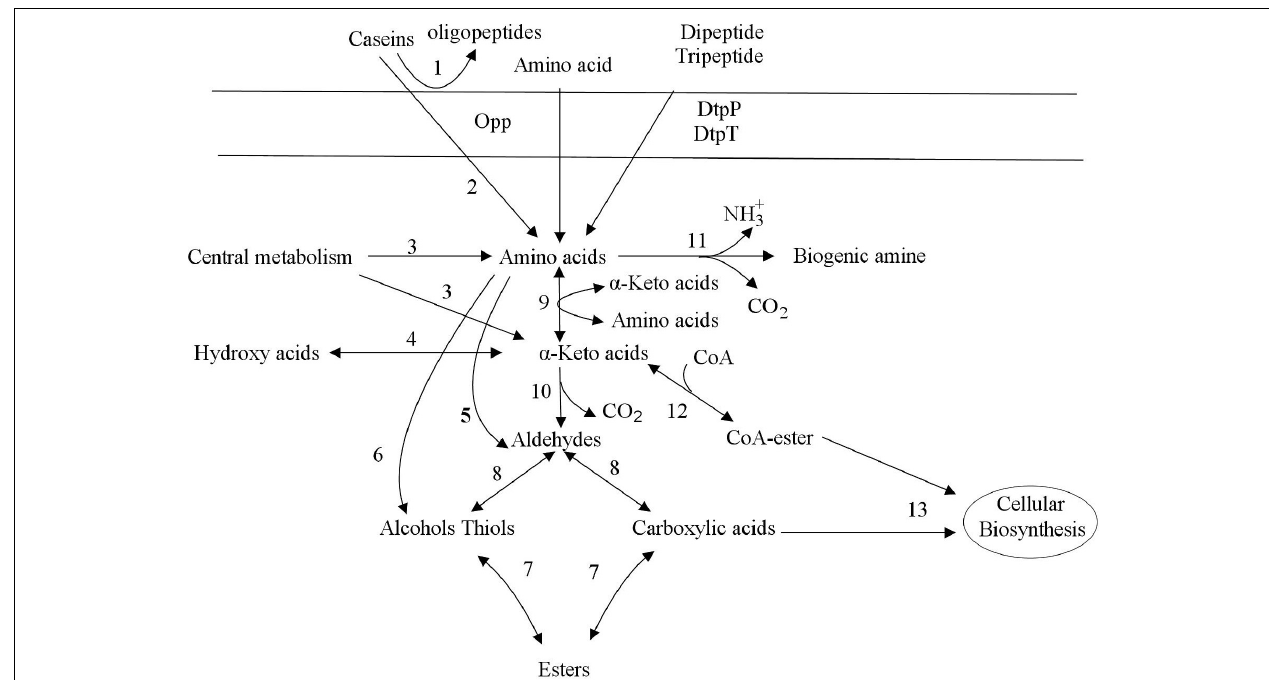
FIGURE 1 | Decomposition of protein and metabolism of amino acids (Smit et al., 2005). Proteolysis in lactic acid bacteria is initiated by cell envelope proteinase (CEP), which degrades proteins into oligopeptides. The second stage of protein degradation is the transfer of dipeptides, tripeptides, and oligopeptides into cells. Three transport systems have been found in lactic acid bacteria, namely oligopeptide, dipeptide and tripeptide transport systems (Opp, DtpP, and DtpT, respectively). Finally, the Pep family hydrolyzes dipeptides, tripeptides, and oligopeptides into amino acids. The metabolism of amino acids includes deamination and decarboxylation. The deamination reaction produces various α -carboxylic acids, which are involved in various metabolisms in lactic acid bacteria cells. The amino acid decarboxylation reaction produces biogenic amines, which mainly includes the transport of amino acids into the cell, decarboxylation, and transport outside the cell after being converted into biogenic amines. Transamination of amino acids leads to the formation of alpha-keto acids. Alpha-keto acids can be converted to aldehydes by decarboxylation. Aldehydes are converted to alcohols or carboxylic acids by dehydrogenation. The direct dehydrogenation of alpha-keto acids leads to the formation of hydroxy acids. 1: cell envelope proteinase, 2: peptidases, 3: biosynthetic enzymes, 4: dehydrogenase, 5: aldolases, 6: lyases, 7: acyltransferases esterases, 8: dehydrogenase, 9: aminotransferases, 10: decarboxylase, 11: deiminases decarboxylase, 12: dehydrogenase complex, 13: biosynthetic